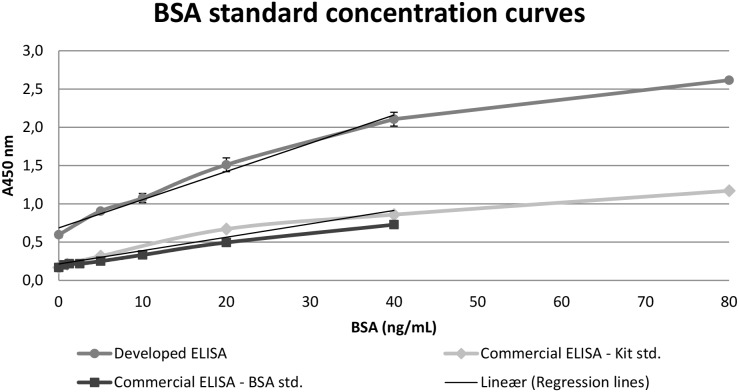
Concentration curves for developed and commercial BSA ELISAs.The optimal sandwich ELISA (table 1, setup 15) including the in-house BSA standards (std.) from 0–80 ng/mL (Developed ELISA). Capture antibody at a 1∶400 dilution, primary antibody at a 1∶800 dilution and secondary antibody at a 1∶1000 dilution. With the commercial BSA ELISA the in-house BSA standards (Commercial ELISA – BSA std.) were tested in addition to the commercial kit BSA standards (Commercial ELISA – Kit std.). There were no statistically significant difference (t-test comparing the slopes of the regression lines, p≥0.05) between the datasets of the BSA concentration curve of the developed (y = 0.0368 · x+0.686, r = 0.9853) and commercial ELISA (y = 0.0175·x+0.2144, r = 0.9534) in BSA concentration ranging from 0–40 ng/mL. Data is expressed as mean ± SD (n = 3) or mean (n = 2).